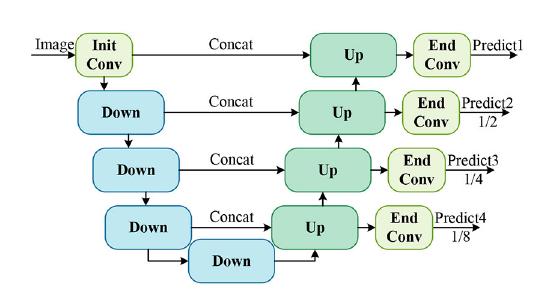
FIGURE4 Detailed structure of scene encoder and location